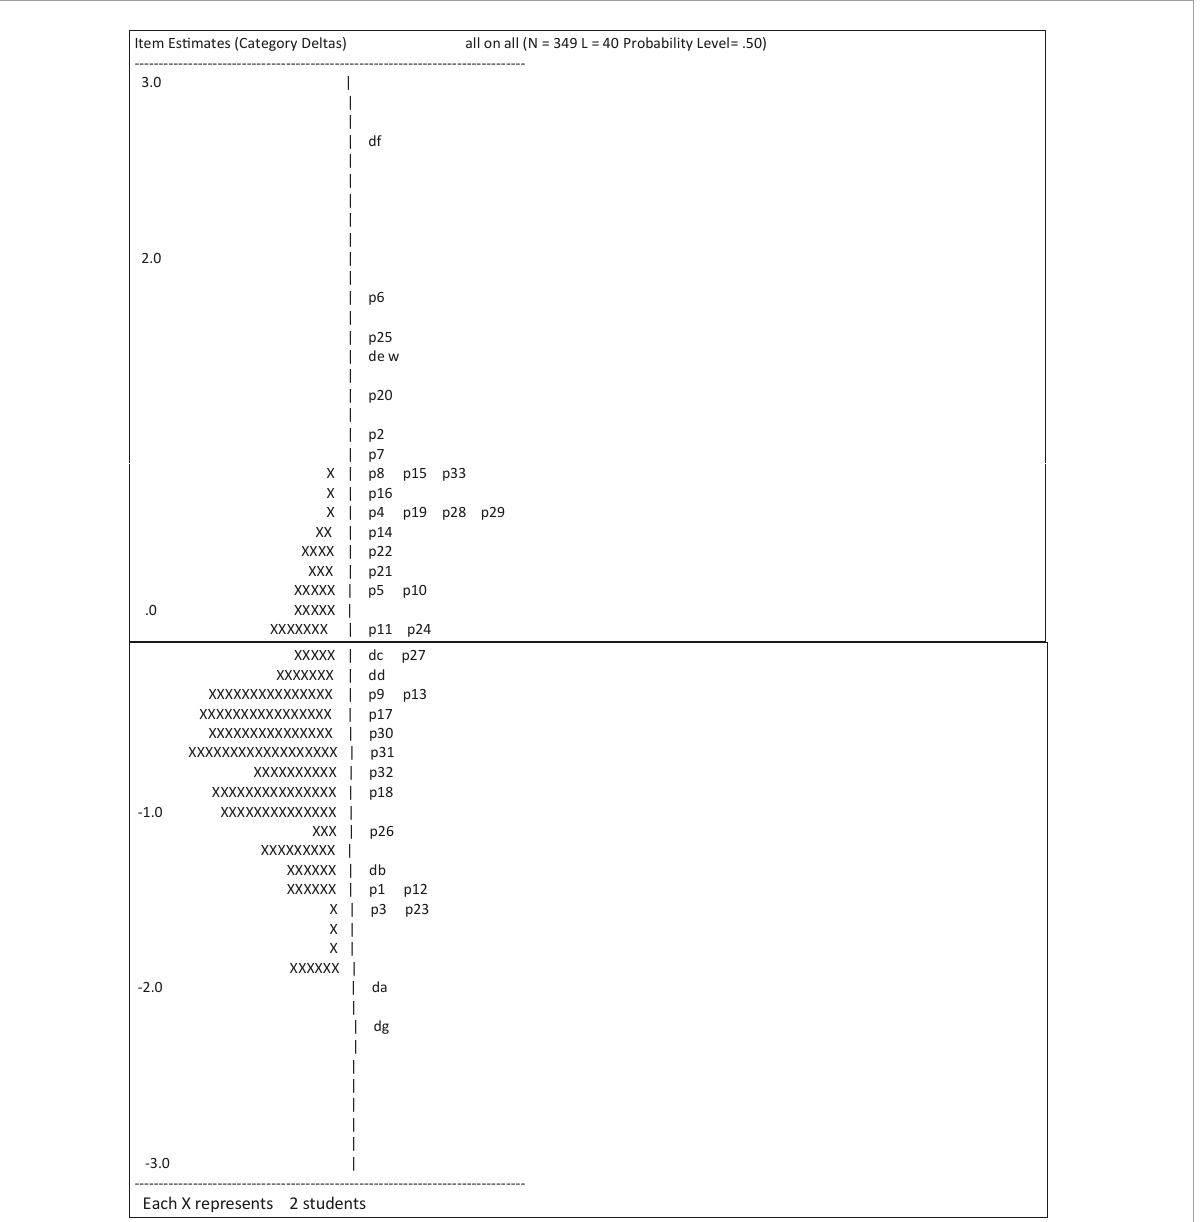
with the invariance of factor variances, factor co-variances, and factor